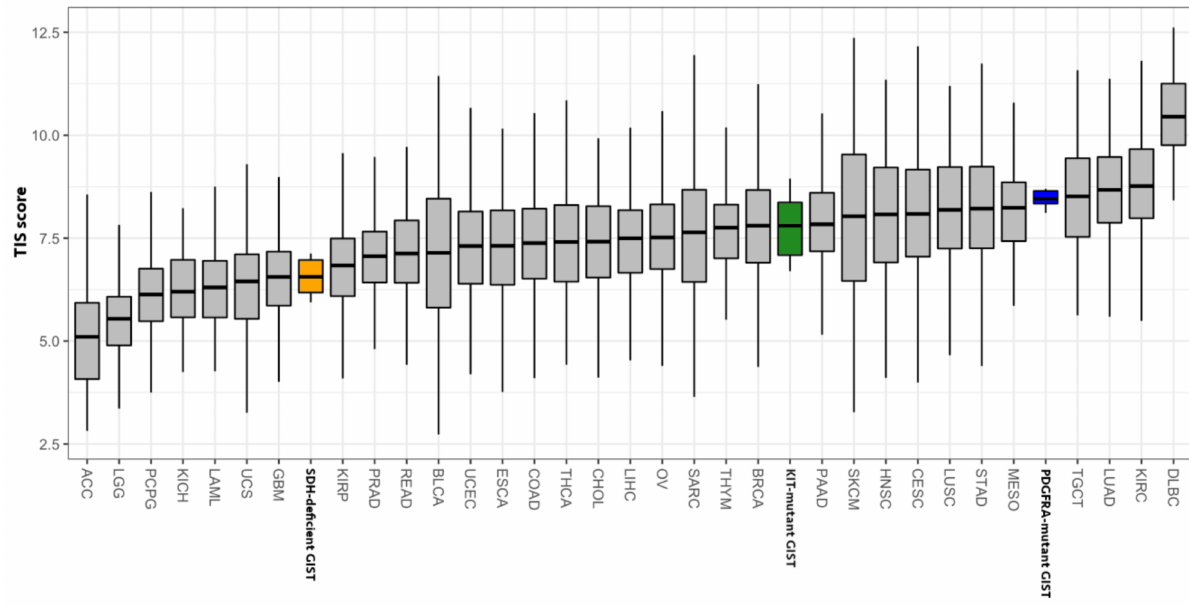
Figure 6. T-cell-inflamed signature score of GISTs (SDH-deficient GISTs in orange, KIT-mutant GISTs in green, and PDGFRA- mutant GISTs in blue) and other solid tumor types from The Cancer Genome Atlas (TCGA). ACC: adrenocortical carcinoma; BLCA: bladder urothelial carcinoma; BRCA: breast invasive carcinoma; CESC: cervical squamous cell carcinoma and endocervical adenocarcinoma; CHOL: cholangiocarcinoma; COAD: colon adenocarcinoma; DLBC: lymphoid neoplasm diffuse large B-cell lymphoma; ESCA: esophageal carcinoma, GBM: glioblastoma multiforme; HNSC: head and neck squamous cell carcinoma; KICH: kidney chromophobe; KIRC: kidney renal clear cell carcinoma; KIRP: kidney renal papillary cell carcinoma; LAML: acute myeloid leukemia; LGG: brain lower-grade glioma; LIHC: liver hepatocellular carcinoma; LUAD: lung adenocarcinoma; LUSC: lung squamous cell carcinoma, MESO: mesothelioma; OV: ovarian serous cystadenocarcinoma; PAAD: pancreatic adenocarcinoma; PCPG: pheochromocytoma and paraganglioma; PRAD: prostate adenocarcinoma; READ: rectum adenocarcinoma; SARC: sarcoma; SKCM: skin cutaneous melanoma; STAD: stomach adenocarcinoma; TGCT: testicular germ cell tumors; THCA: thyroid carcinoma; THYM: thymoma; UCEC: uterine corpus endometrial carcinoma; UCS: uterine carcinosarcoma; UVM: uveal